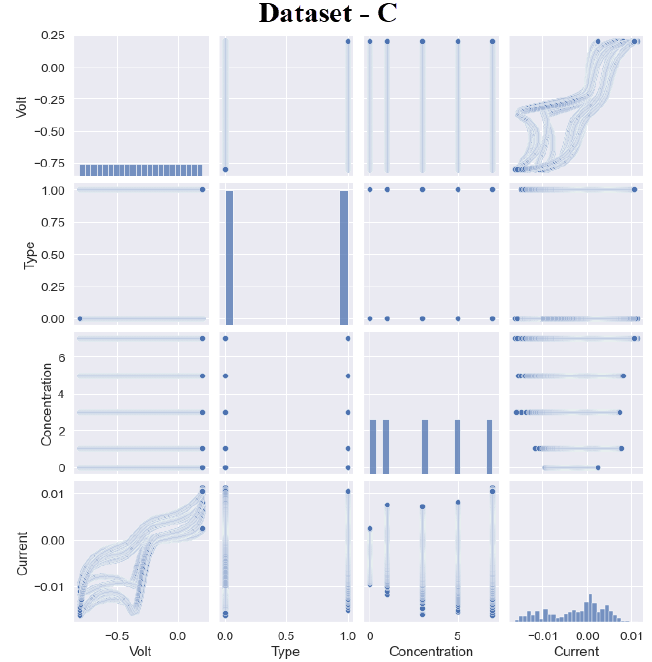
Figure 13. Pair distribution plots of Dataset C.